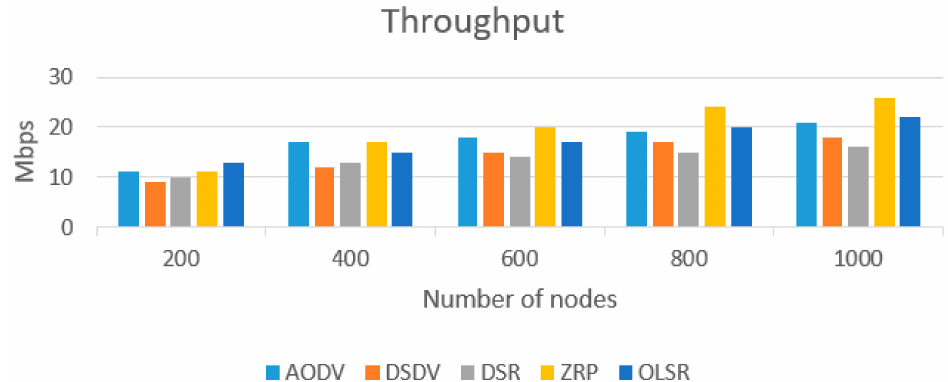
Figure 5. Comparative analysis of throughput in 200–1000-node networks using the proposed scheme over five MANET routing protocols.